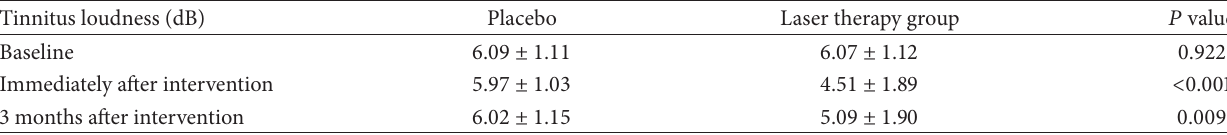
Table 2: Comparison of tinnitus loudness between two groups at baseline, immediately and 3 months after intervention. Tinnitus loudness (dB) Placebo